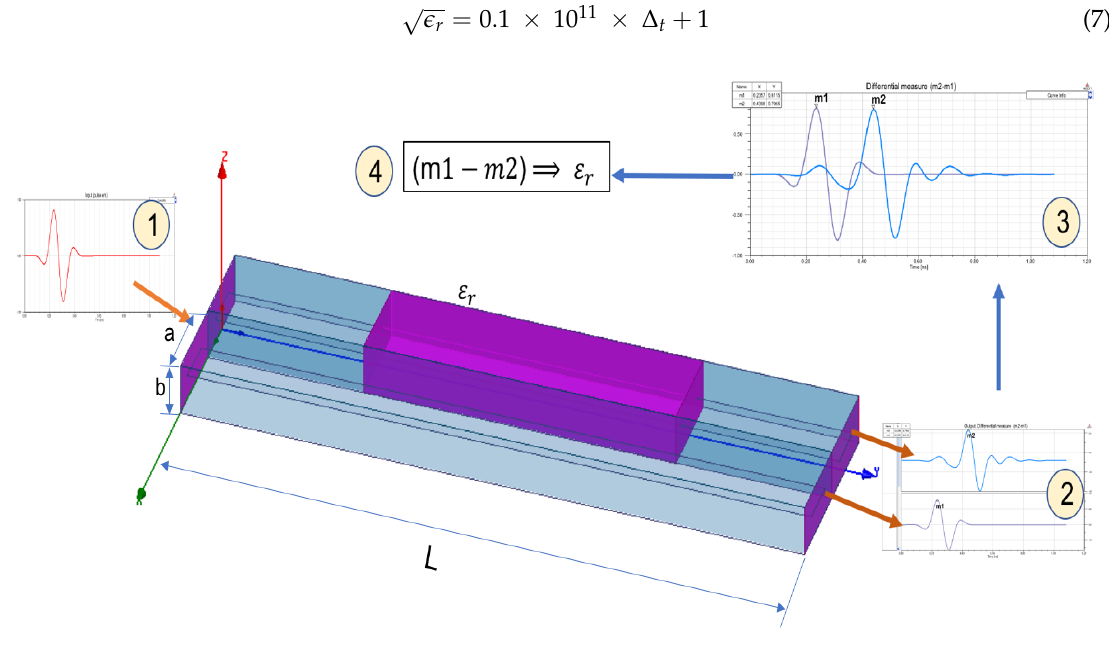
Figure 4. Rectangular wave guide ( L = 60 mm, a = 7.894 mm and b = 3.947 mm) used in propagation simulation built with two differentiated transmission lines. One input signal is transmitted (1) to the waveguide and derived into the two transmission lines. Two output ports signals are obtained (2) and time difference of arrival between two waves are obtained (3). The difference measured (4) characterize medium (cid:101) r .